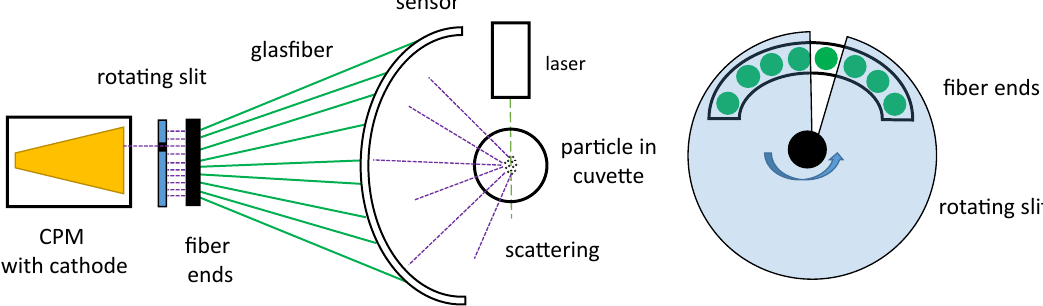
Figure 13. ( a ) Fiber sensor in a semi circle form to detect scattered light over a range of angles and forward it to the customized photon multiplier (CPM). Between the sensor and the CPM is a rotating slit which allows only the signal from one fiber at a time to reach the CPM. ( b ) The fiber ends are placed